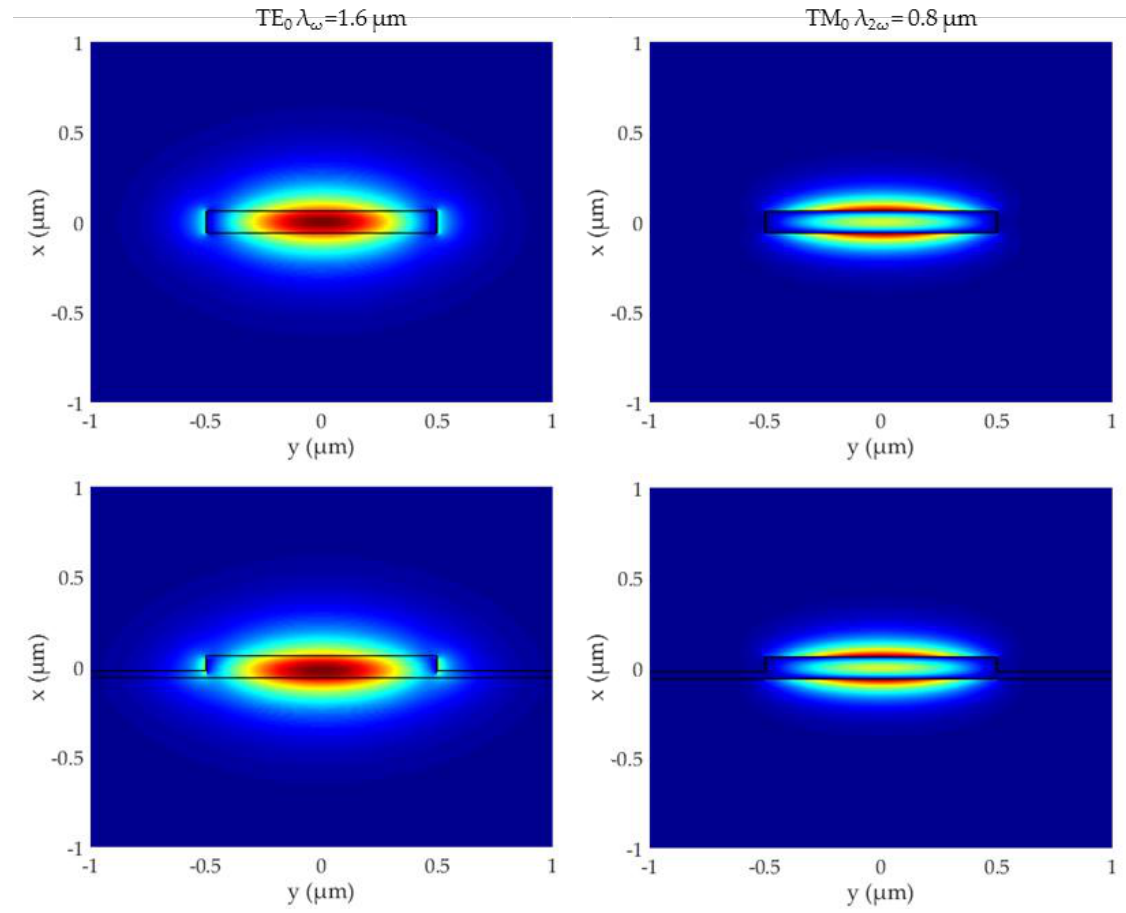
Figure 3. TE 00 amplitude at ω (E y , left) and TM 00 amplitude at 2ω (E x , right) in the suspended nanowire (top) and rib waveguide (bottom).